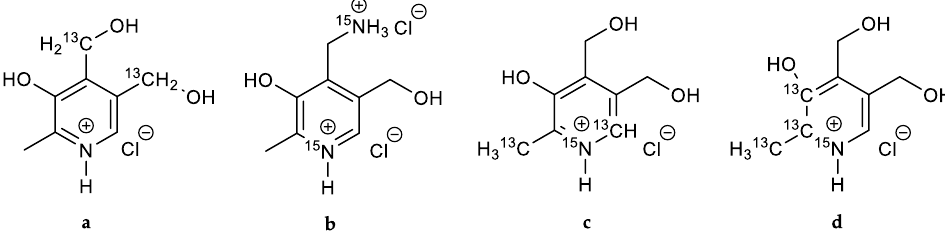
Figure 2. B6 vitamers ( a – d ) with different isotopically labelled positions/ atoms reported in the literature [31,32,43 – 48].